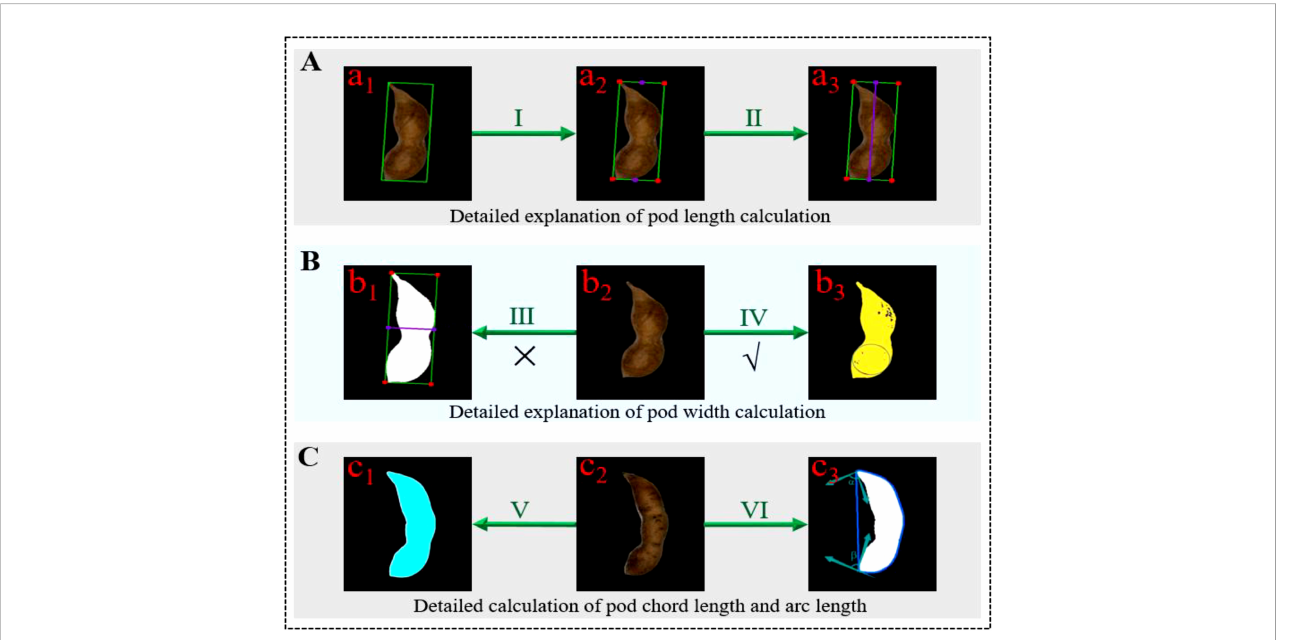
FIGURE 8 Steps for calculating phenotypic traits of a single pod (A) Calculation of pod length; (B) Calculation of the pod width; (C) Calculation of pod area, chord length and arc